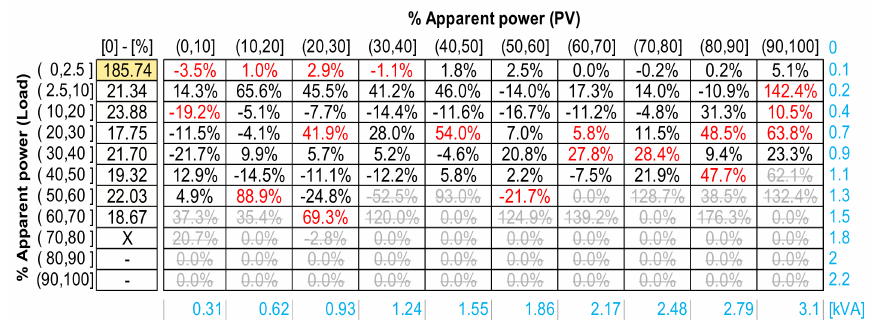
Figure 20. Matrix of total harmonic distortion of current (THDI) values for PVS Of f scenarios and variations of THDI values for PVS On scenarios of Phase A.